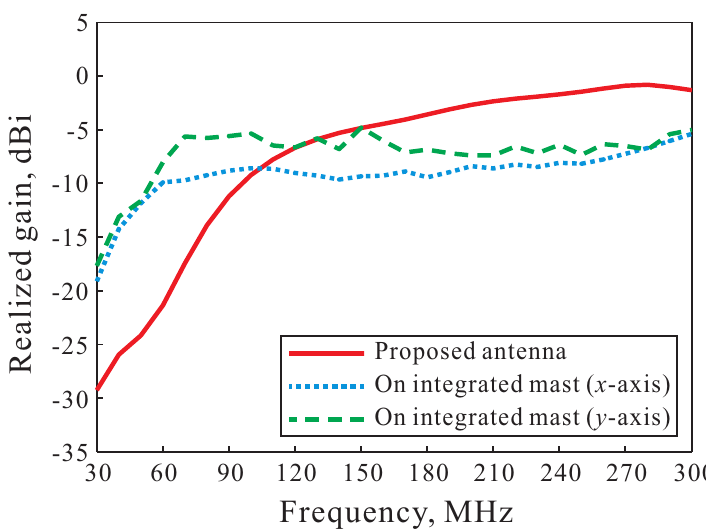
Figure 9. Simulated realized peak gains of the proposed antenna mounted on the integrated mast of an OPV and flat ground conditions.